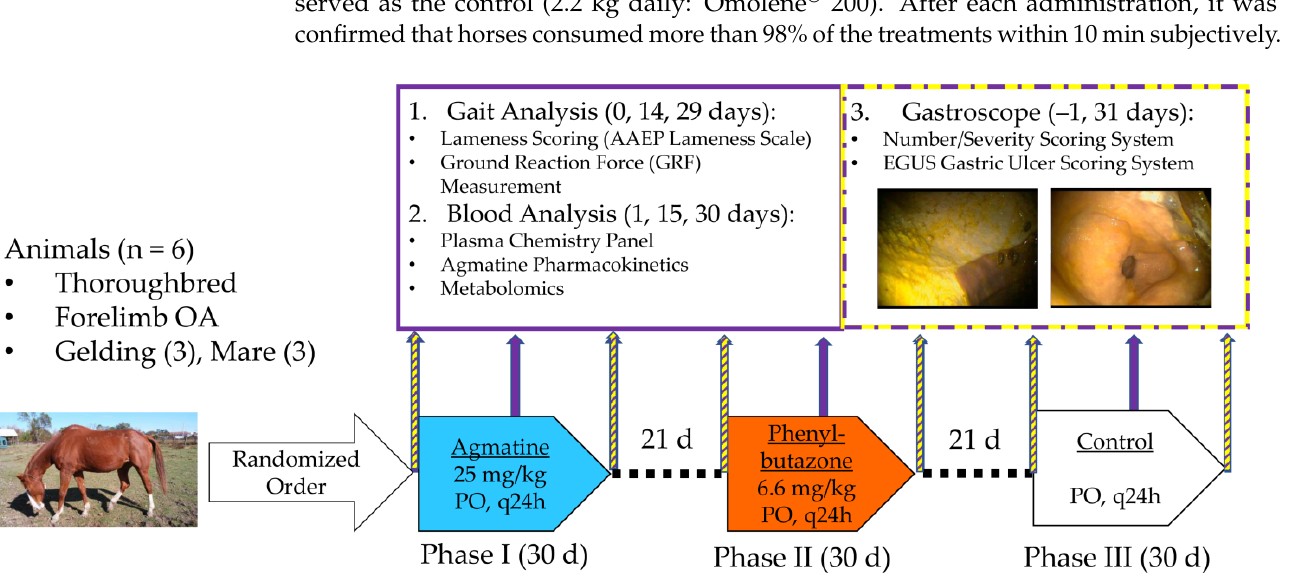
Figure 1. Three-phase, 1 randomized, controlled, crossover study design. Six adult thoroughbred horses with thoracic limb osteoarthritis (OA) received oral agmatine, phenylbutazone, or control in random order. Gait analysis and blood collection were performed before, during, and after each treatment phase, while gastroscopy was performed before and after. AAEP: American Association of Equine Practitioners; EGUS: equine gastric ulcer syndrome; PO: per os.